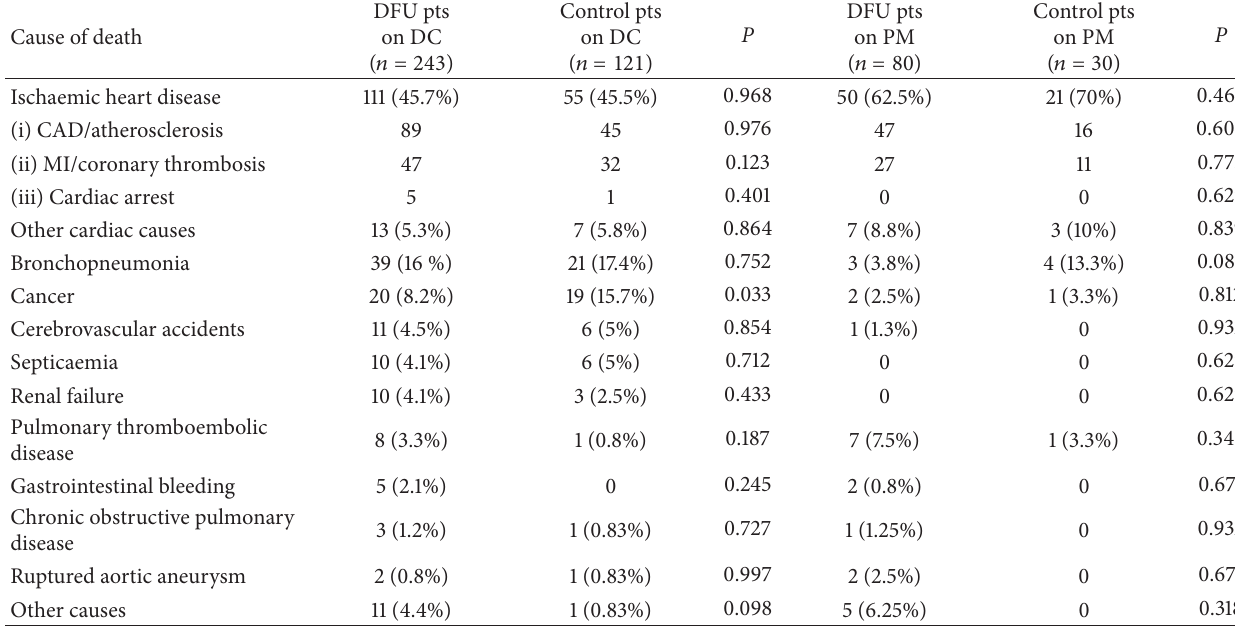
Table 2: Causes of death in diabetic foot ulcer patients and control group on death certification and postmortem examination. DFU pts Cause of death